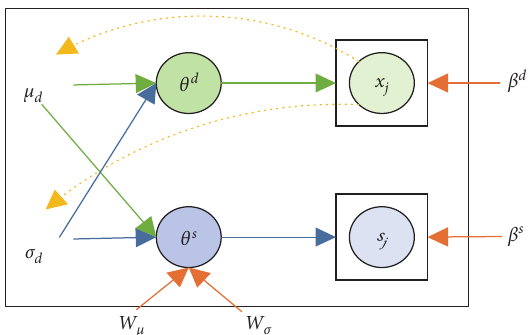
Figure 2: Schematic diagrams of CANTM probability diagram (the solid line represents the generation process, and the dashed line represents the variational inference